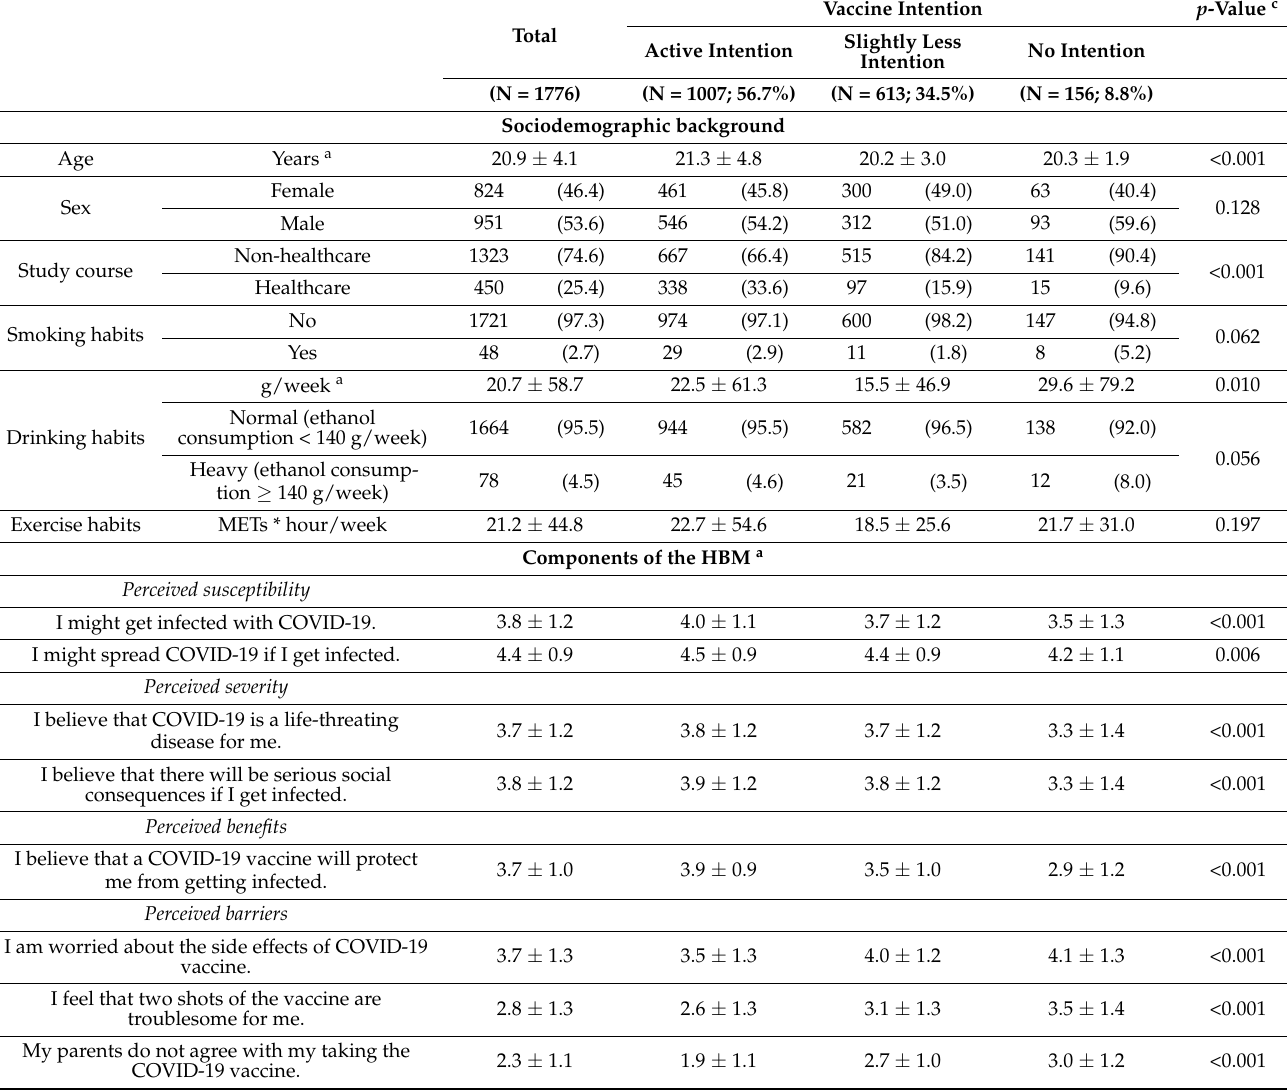
Table 1. Sociodemographic background, health belief model (HBM), and concerns over the COVID-19 surrounding situation according to vaccine